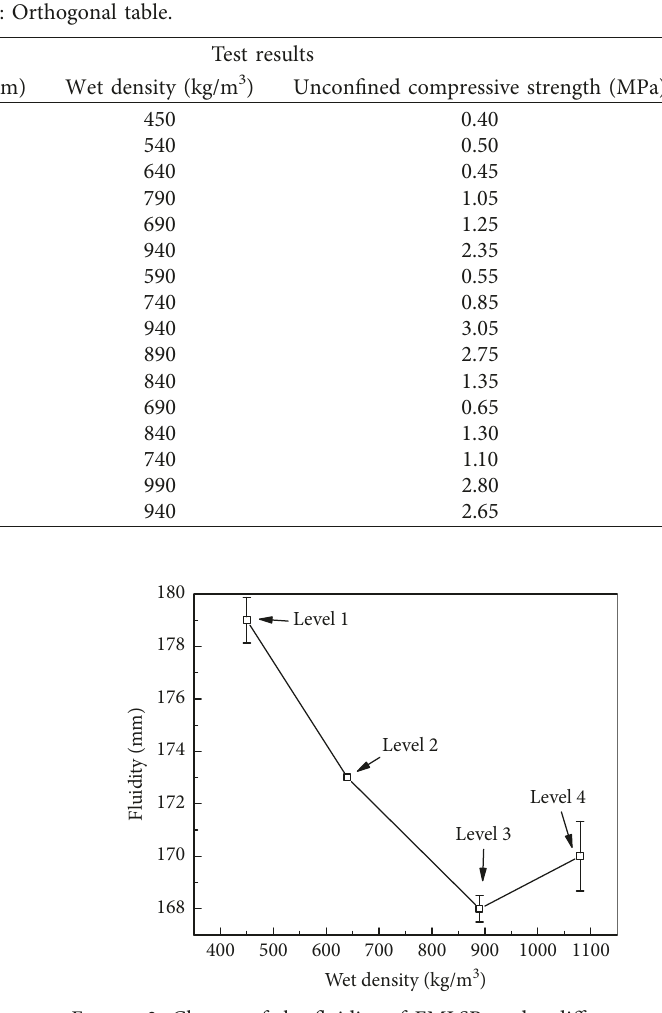
Figure 3: Change of the fluidity of FMLSB under different wet